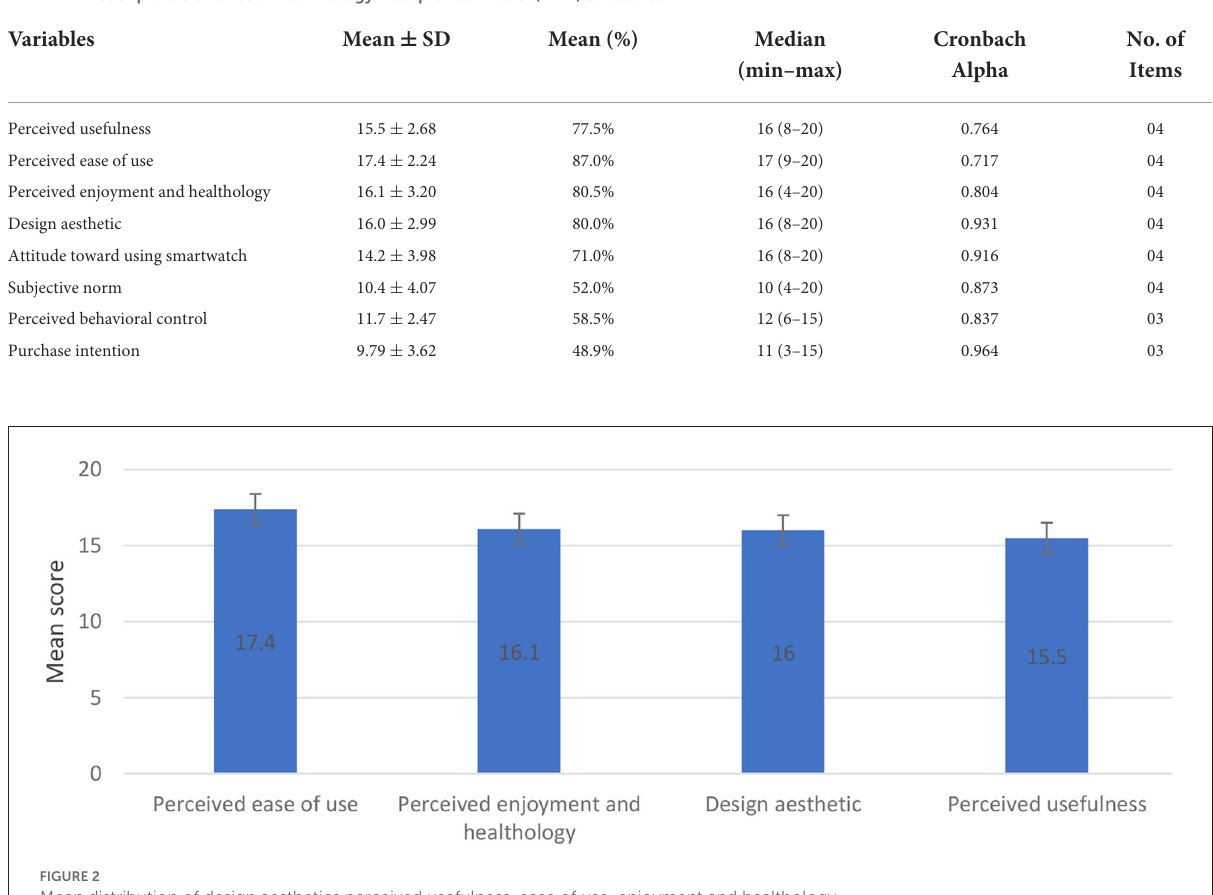
factors influencing the intention to use smartwatches in the Kingdom of Saudi